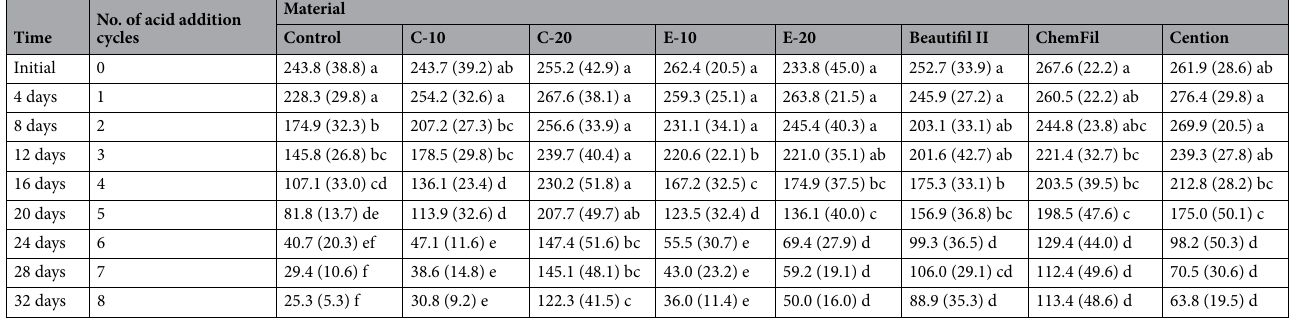
Table 3. Knoop microhardness of enamel blocks (mean values with standard deviations in parentheses). Same letters denote statistically similar microhardness values within a